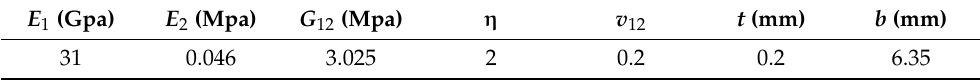
Table 3. Material properties of prepreg and elastic foundation